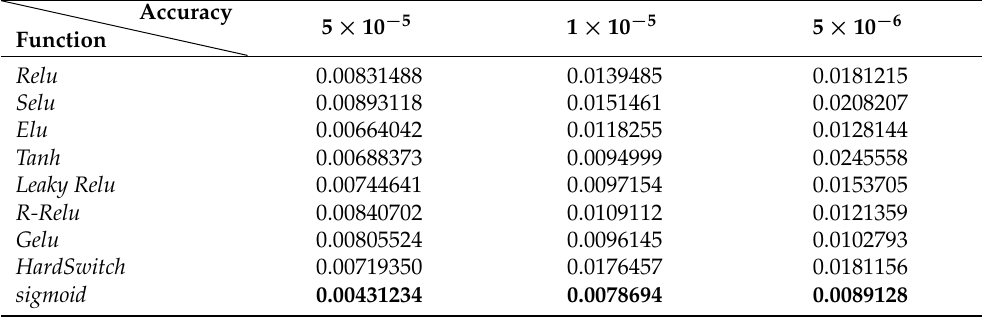
Figure 11. Three curves that perform best at each depth using the Sigmoid function. Table 1. RMS of 9 activation functions with four layers of convolution and two strides. Italic indicates the activation function, and bolded indicates the minimum RMS